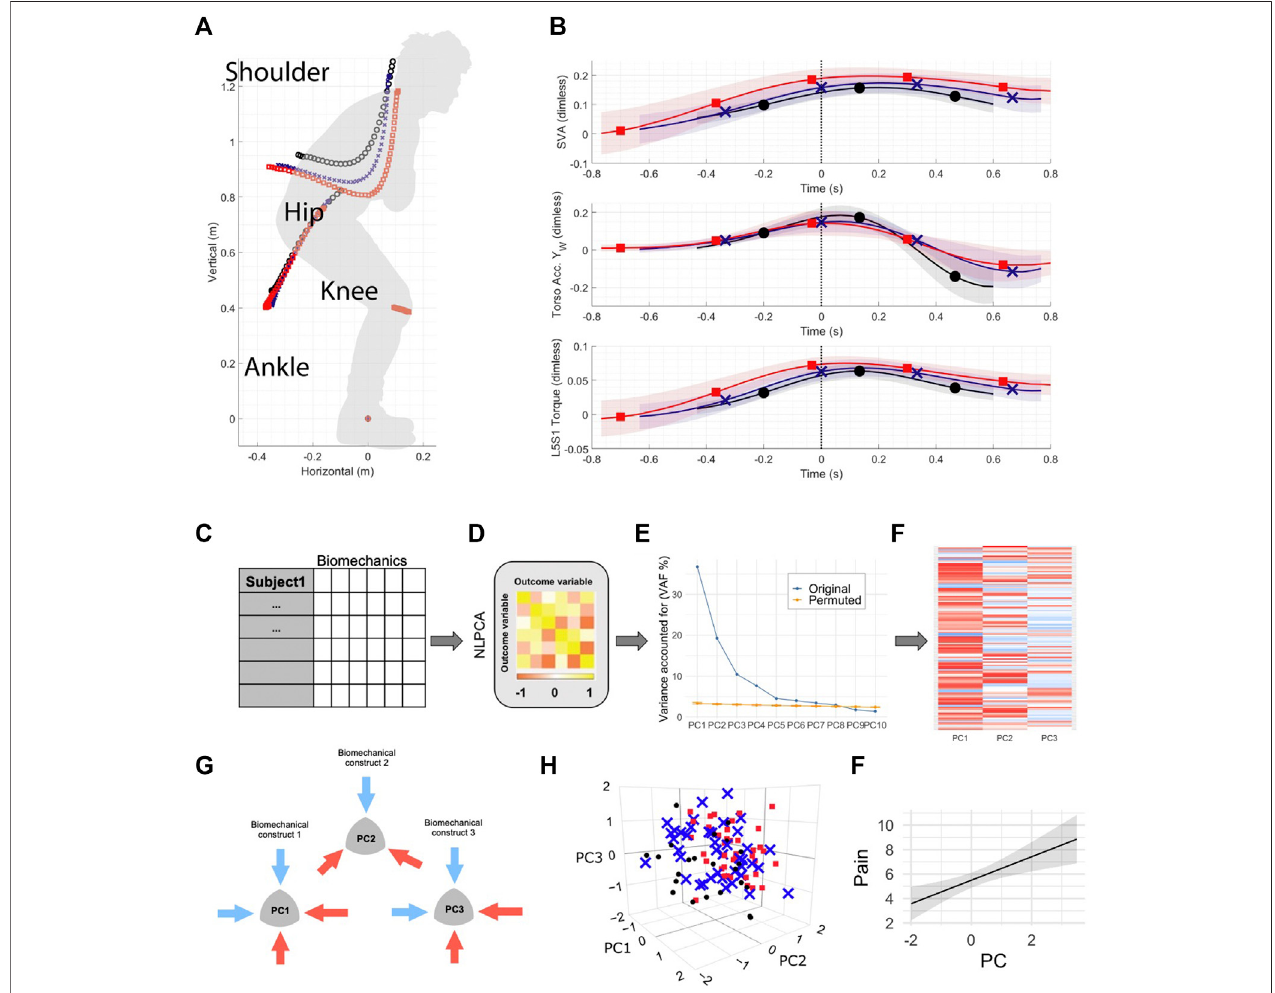
FIGURE1| Unsupervisedmachinelearningonfullbodybiomechanicsanalyticalwork fl ow. (A) Healthycontrol(n=23),patientswithnon-speci fi clowbackpain(n= 43) and patients with spinal deformity (n = 42) were assessed using full body biomechanics (59 variables) during sit-to-stand movement. (B) Full time series data were summarized into minimum and maximum for each variable (total of118 variables) for each patient. Here, the time series trajectories representgroup mean and standard deviation (black ~ control, blue ~ non-speci fi c low back pain patients and red ~ patients with spinal deformity) for one of the variables with a signi fi cant loading in PC1, PC2 or PC3. (C) The resulting dataset was analyzed using nonlinear principal component analysis (D) , followed by a permutation test (E) that determined the numberofprincipalcomponents(PCs)toberetainedwithasigni fi cantnumberofloadingsabove0.5 (F) . (G) The fi rstthreePCswereassessedforconstructvalidity,with subsequentgenerationofthebiomechanicalconstructsofmovementpatterns/strategies. (H) Color-codedvisualizationofgroupsprojectedin3Dspacerevealedgroup separation particularly across PC2. (I) Linear regression models were then used to test whether identi fi ed movement constructs in PC1, PC2, and PC3 could predict patient-reported outcomes of pain and